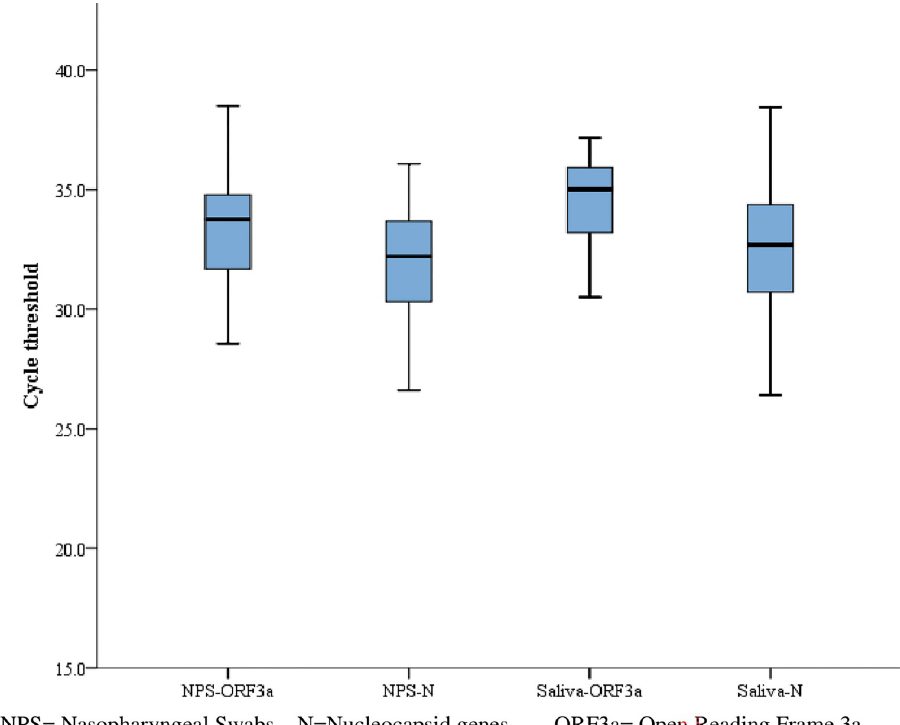
Fig 1. Cycle threshold values of paired ORF3a and N genes from NPS and Saliva samples for SARS-CoV-2 detection using RT-PCR among COVID-19 suspects.